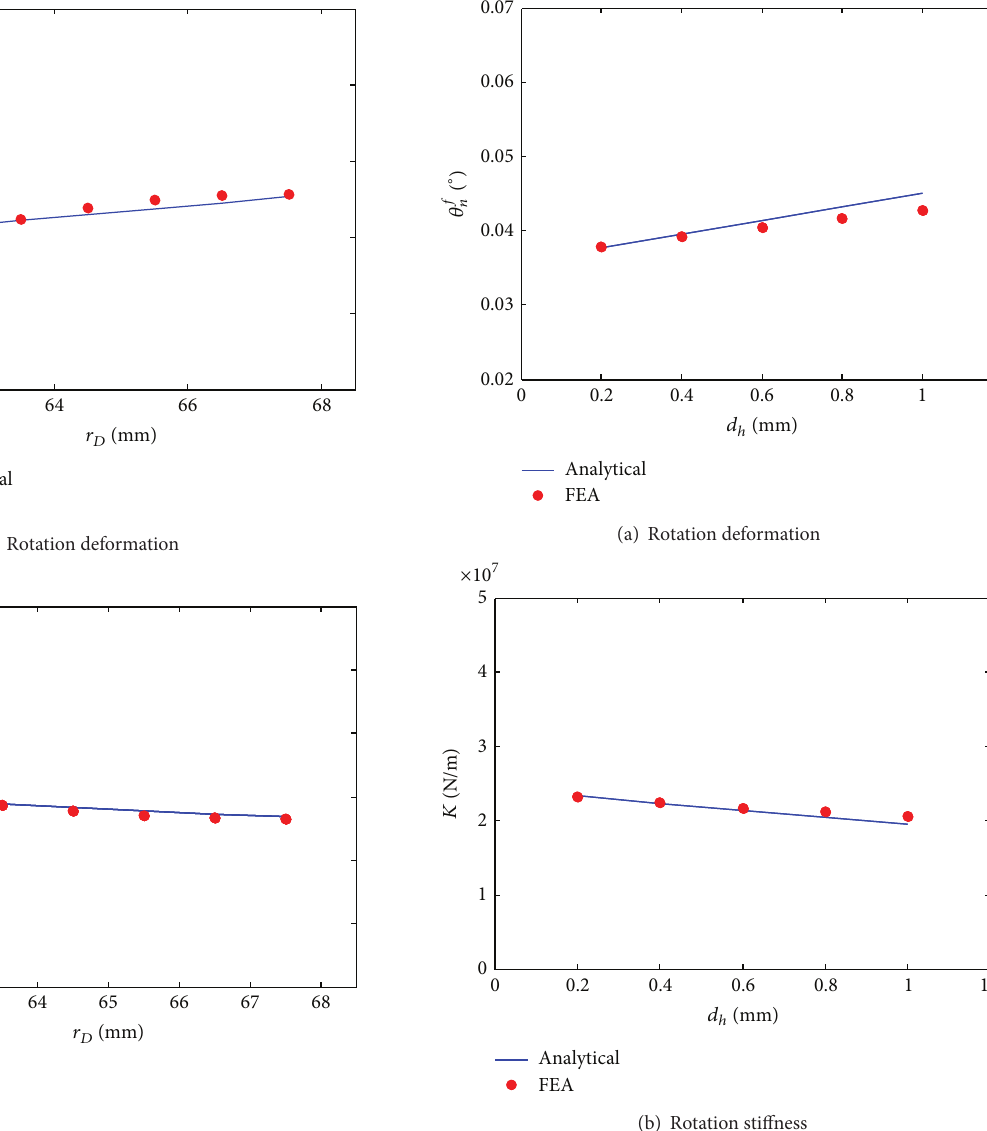
Figure 9: Rotation stiffness and deformation of nut flank with variation of 𝑑 𝑛